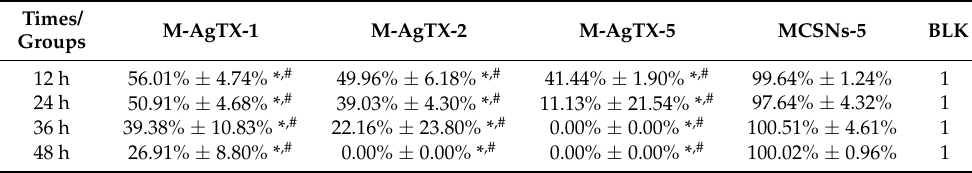
Table 3. Survival rate (%) of MCSNs and M-AgTX against planktonic E. faecalis .